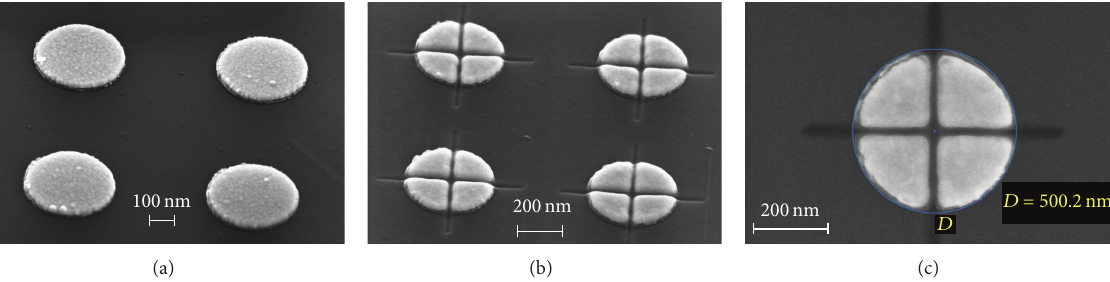
Figure 5: Tilted view (a-b) and plane view (c) SEM micrographs of 40nm thick segmented gold islands made by overlaid milling of crossing lines. Localized surface plasmons interact through the approximately 20 nm wide gaps that were intentionally overmilled deeper into the silicon, as this feature was predicted to favorably affect electromagnetic field enhancement between the gold segments in the near infrared spectral range